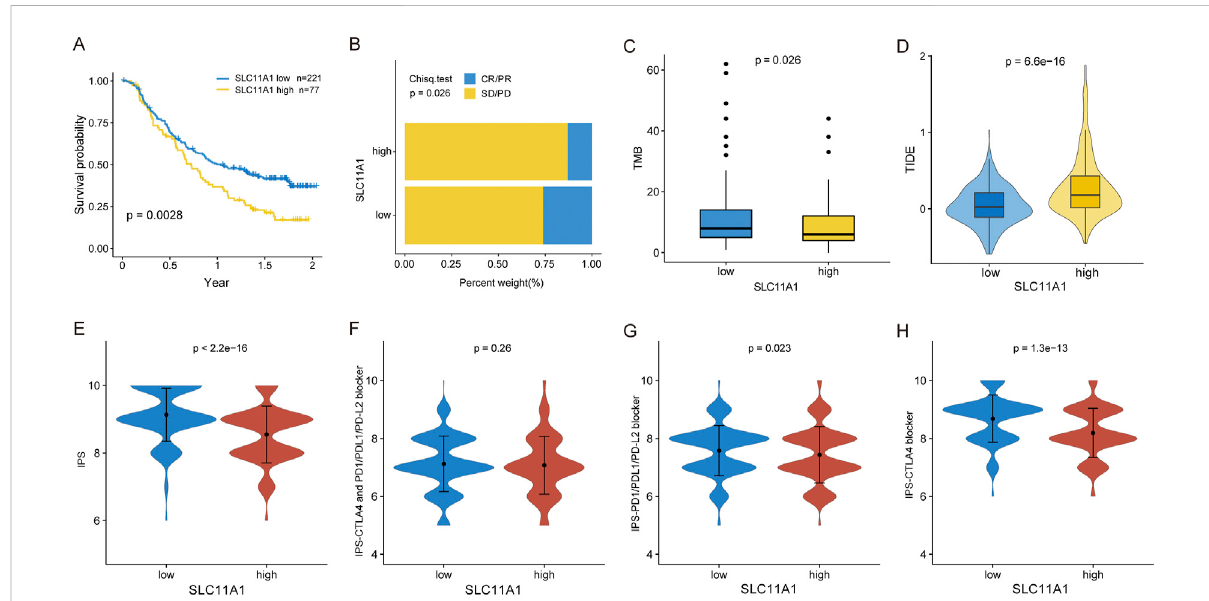
FIGURE 7 High SLC11A1 expression was related with immunotherapy resistance. (A) KM plot for the low- and high-SLC11A1 groups in IMvigor210 cohort. (B) Bar plot showed immunotherapy ef fi cacy of the two groups. (C) Box plot showed the TMB difference of the two groups by the Wilcoxon test. (D) TIDE scores of TCGA-CRC patients with higher SLC11A1 and lower SLC11A1 expression by the Wilcoxon test. (E – H) Evaluation of IPS differences between the low- and high-SLC11A1 groups with TCIA database by the Wilcoxon